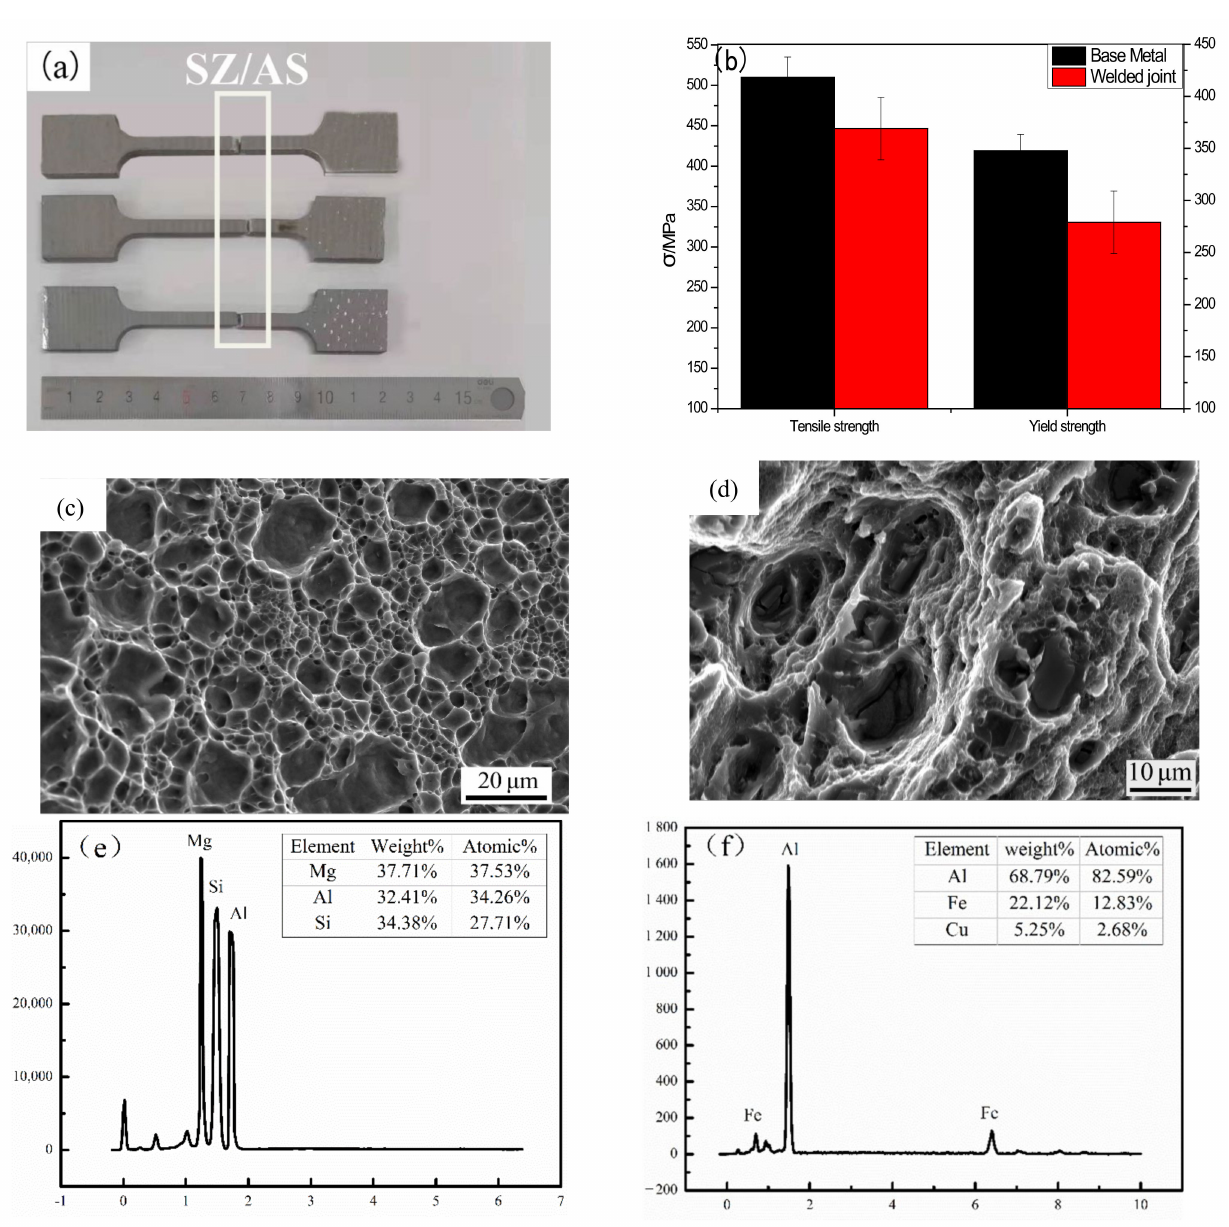
Figure 2. Mechanical properties of FSW joint of 7A52 aluminum alloy ( a ) Fracture location; ( b ) stress–strain curve; ( c , d ) 7A52 aluminum alloy FSW joint fracture organization; ( e ) EDS analysis of Mg2Si; ( f ) EDS analysis of